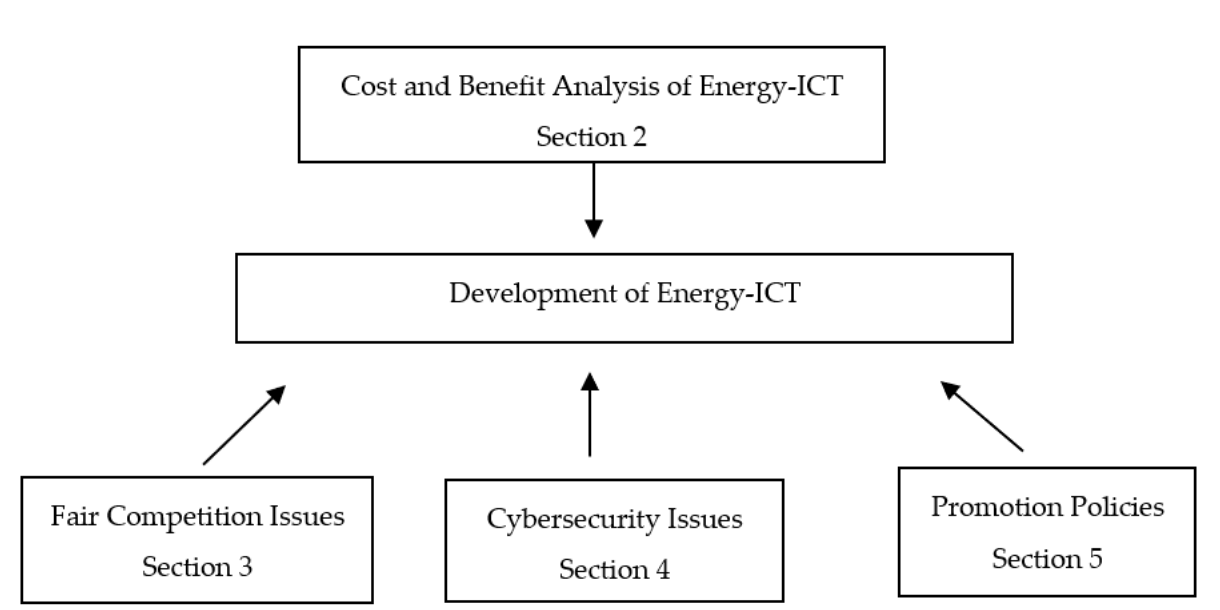
Figure 1. Energy-ICT Literature Review with Economic and Management Viewpoints.